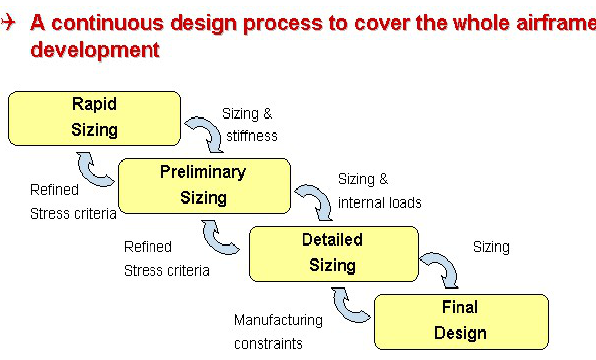
Fig. 26: Cascade of sizing stages and potential